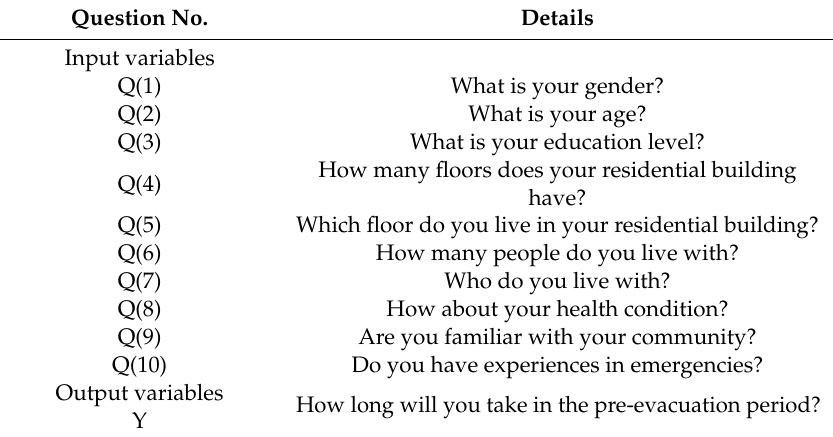
Table 1. Major questions involved in the prediction